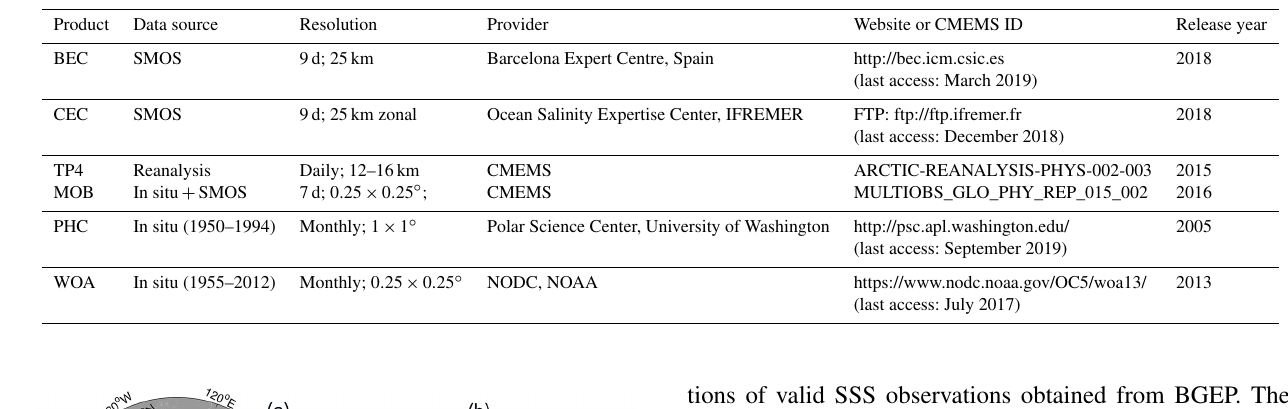
Table 1. Details of the six products evaluated during 2011–2013.